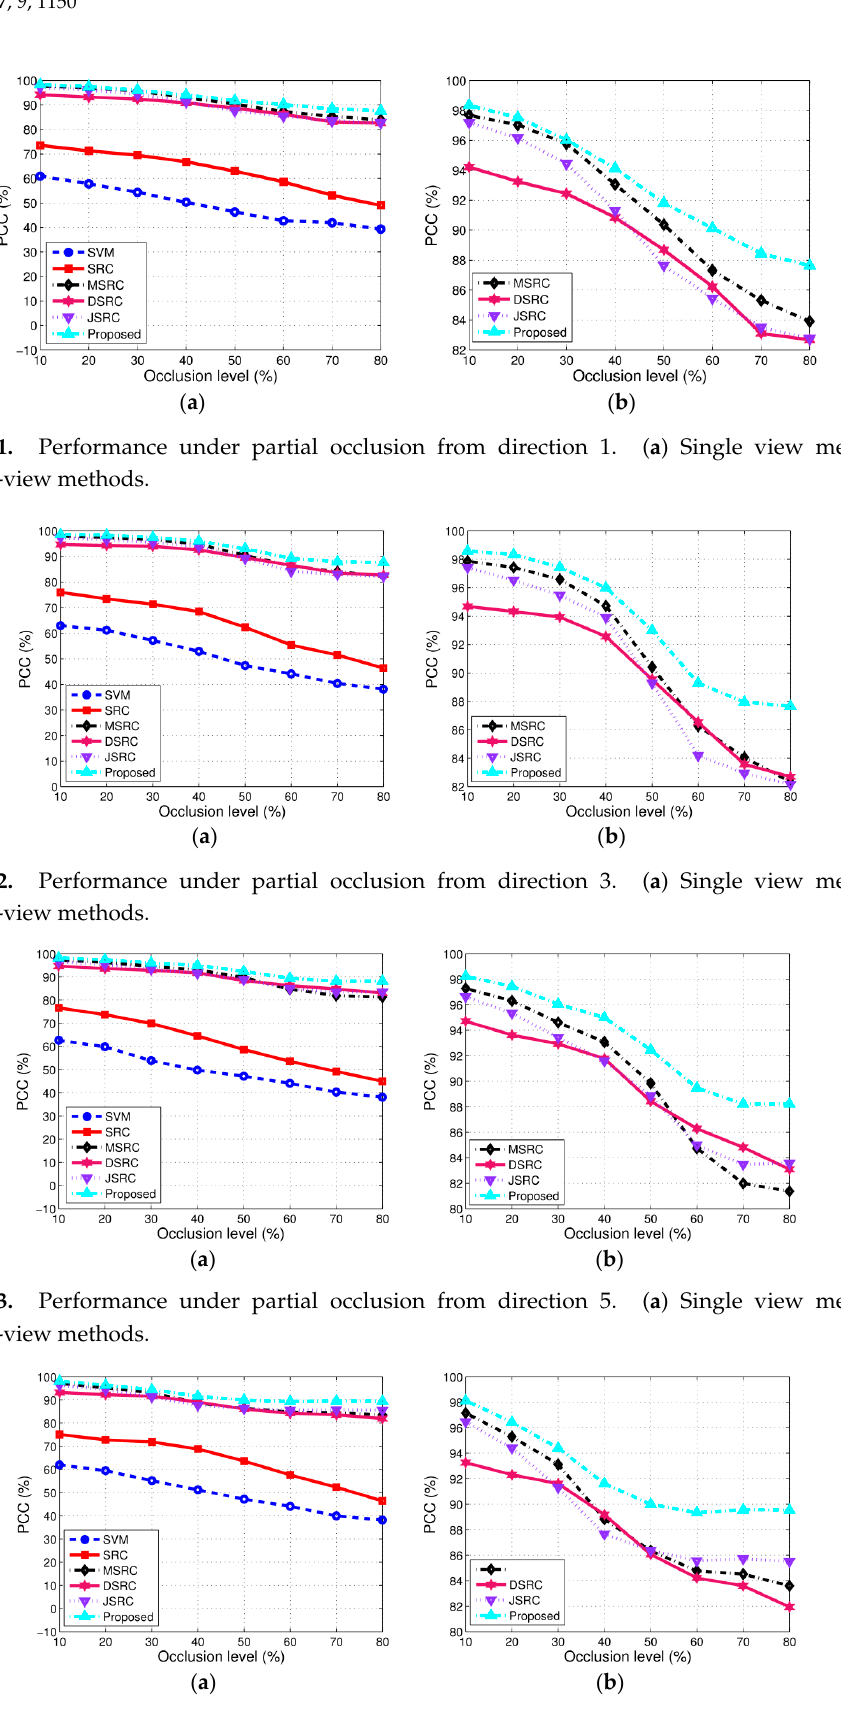
Figure 14. Performance under partial occlusion from direction 7. ( a ) Single view methods; ( b ) Multi-view methods